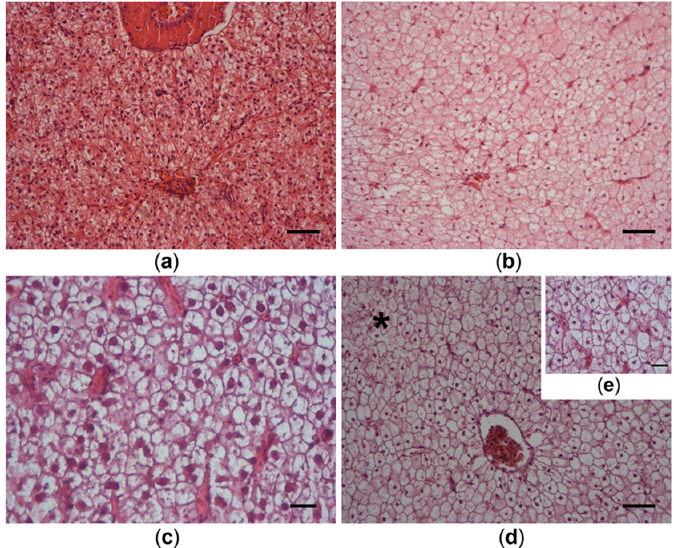
Figure 4. Histopathological alterations in the liver of Prussian carp Carassius gibelio from Lake Ludoš, 2018: ( a ) control fish; ( b ) loss of the cord-like parenchymal structure; ( c ) rounding of hepatocytes; ( d ) necrotic fields (asterisk) with hepatocytes displaying karyopyknosis; ( e ) hepatocytes displaying vacuolization and glycogen depletion. Haematoxylin and eosin (H&E) staining. A, B and D–50 μ m; C and E–20 μ m.